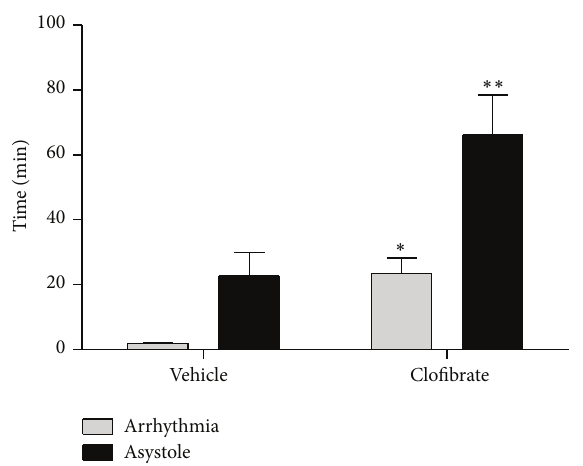
Figure 1: Time of onset of arrhythmia and asystole after ouabain incubation in vehicle- and clofibrate-treated groups. Data are shown as mean ± SEM. Six rats were used in each group. ∗ 𝑃 ≤ 0.05 compared to arrhythmia of vehicle group; ∗∗ 𝑃 ≤ 0.05 compared to asystole of vehicle group.